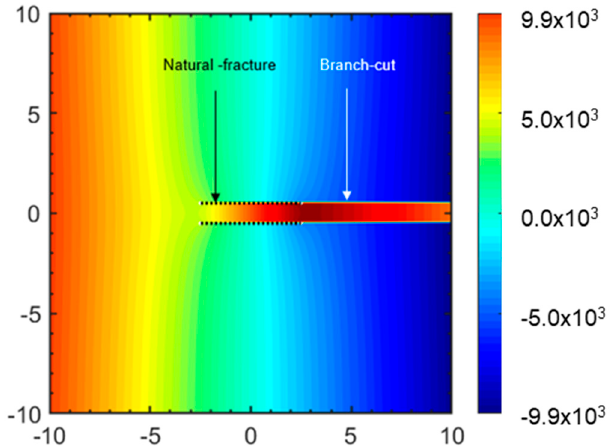
Figure A1. Pressure field for a far-field flow near a fracture. Length scale in m and pressure (rainbow colors) in Pa.